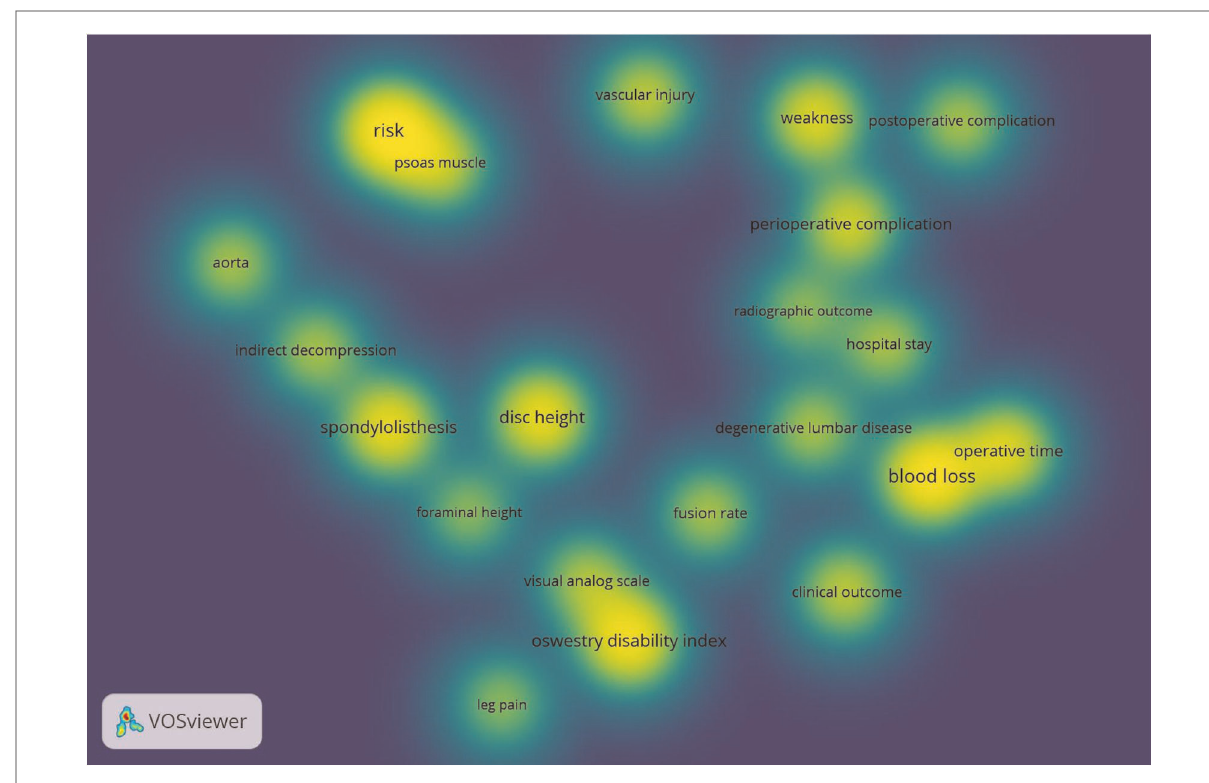
FIGURE 3 Density visualization map of keywords. The density magnitude depends on the number of elements in the surrounding area and the importance of those elements. The higher the density, the brighter the color; conversely, the lower the density, the lighter the